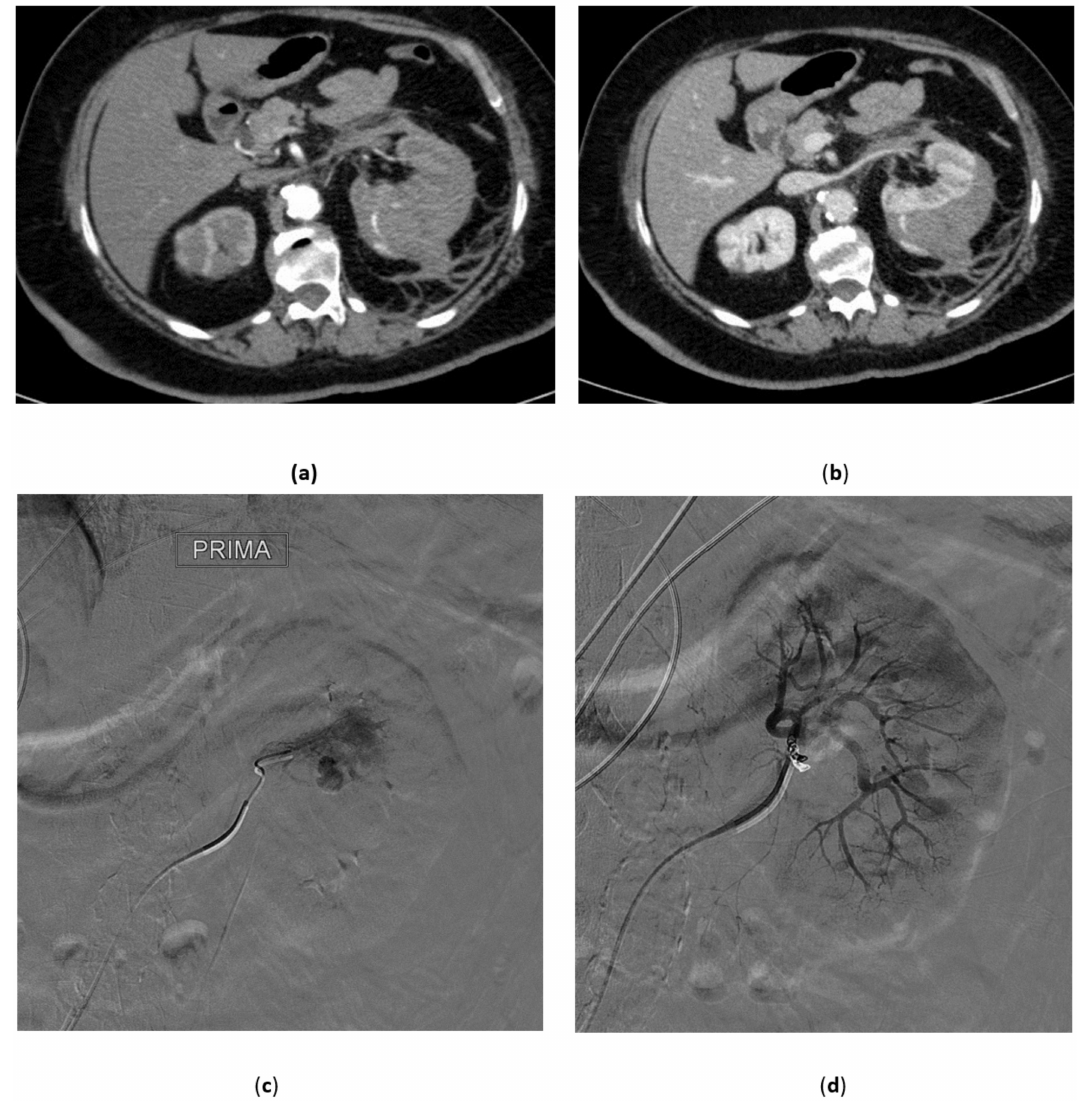
Figure 4. Renal trauma 59-year-old male. Car accident, hematuria. ( a , b ) Contrast-enhanced CT shows a left perirenal hematoma with an active bleeding inside; ( c ) Superselective angiography confirms the bleeding, which was treated by deployment of a microcoil ( d